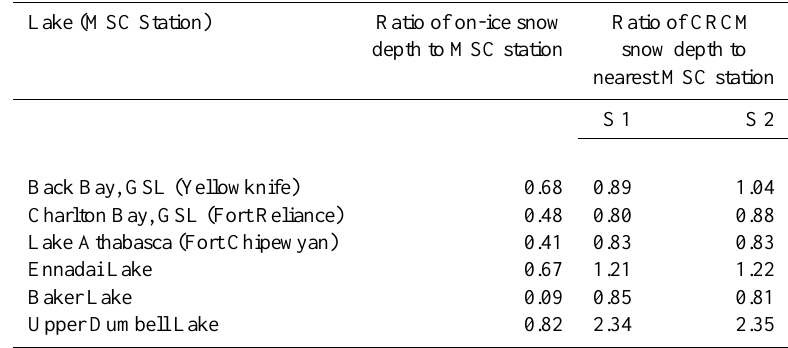
Table 2. Ratio of snow depths measured on-ice and snow depth from the CRCM data with respect to the amounts measured at the MSC weather